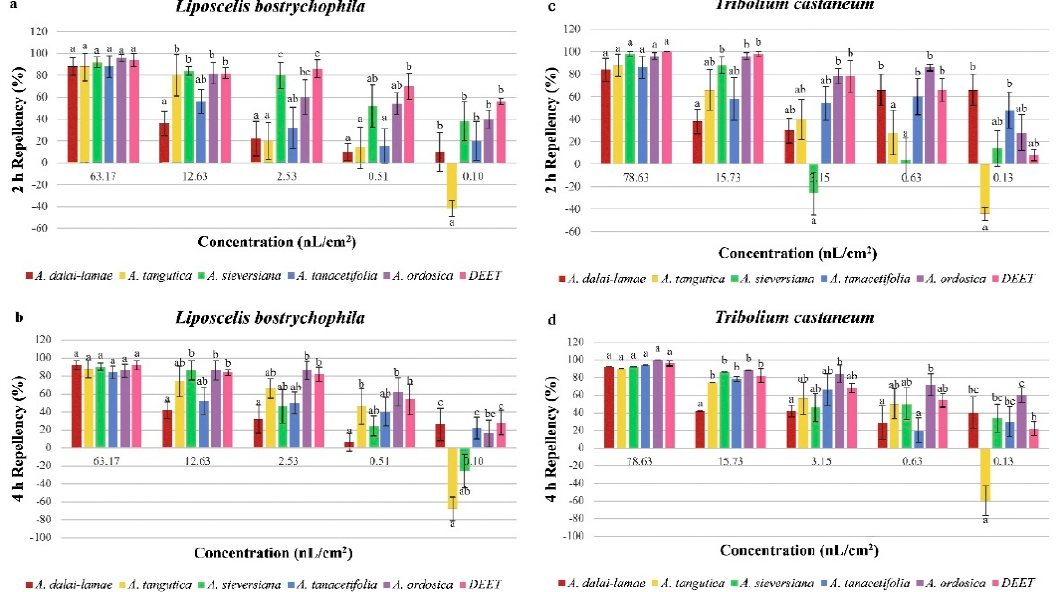
Figure 3. Percentage repellency (PR) value of five Artemisia species essential oil against L. bostry- chophila ( a , b ) and T. castaneum ( c , d ) adults at 2 h ( a , c ) and 4 h ( b , d ) after exposure. Means in the same column followed by the same letters do not differ significantly ( p > 0.05) in ANOVA and Tukey’s